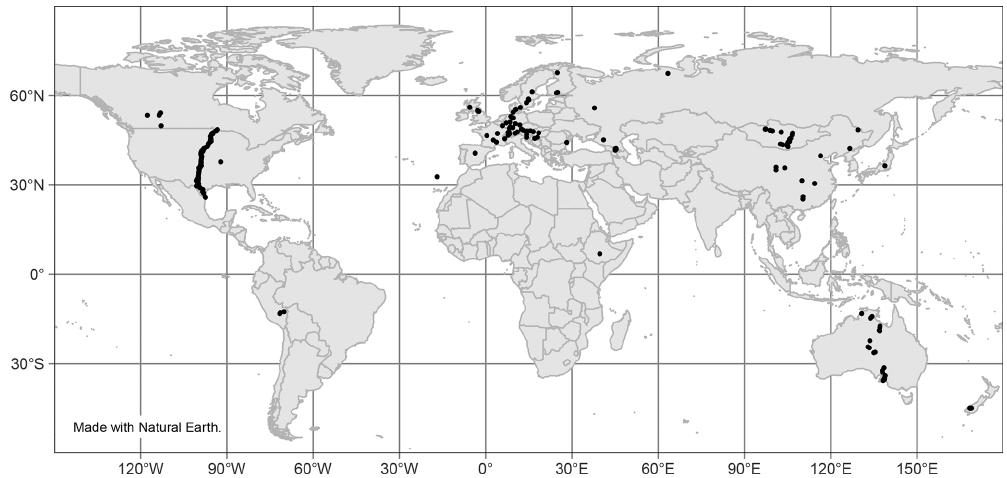
Figure 10. Locations of studies included in data